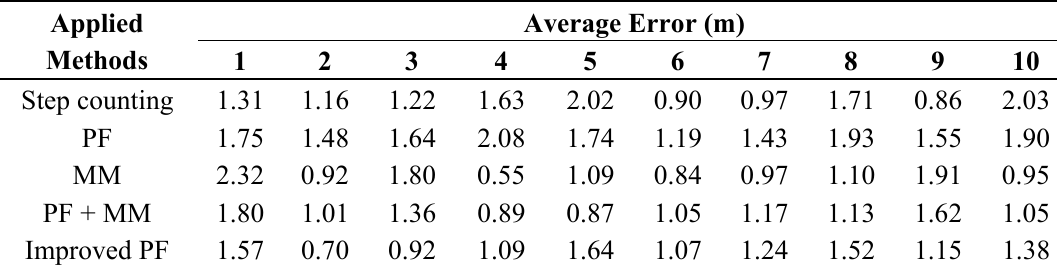
Table 5. Average error for each trial (map 2, route 1).